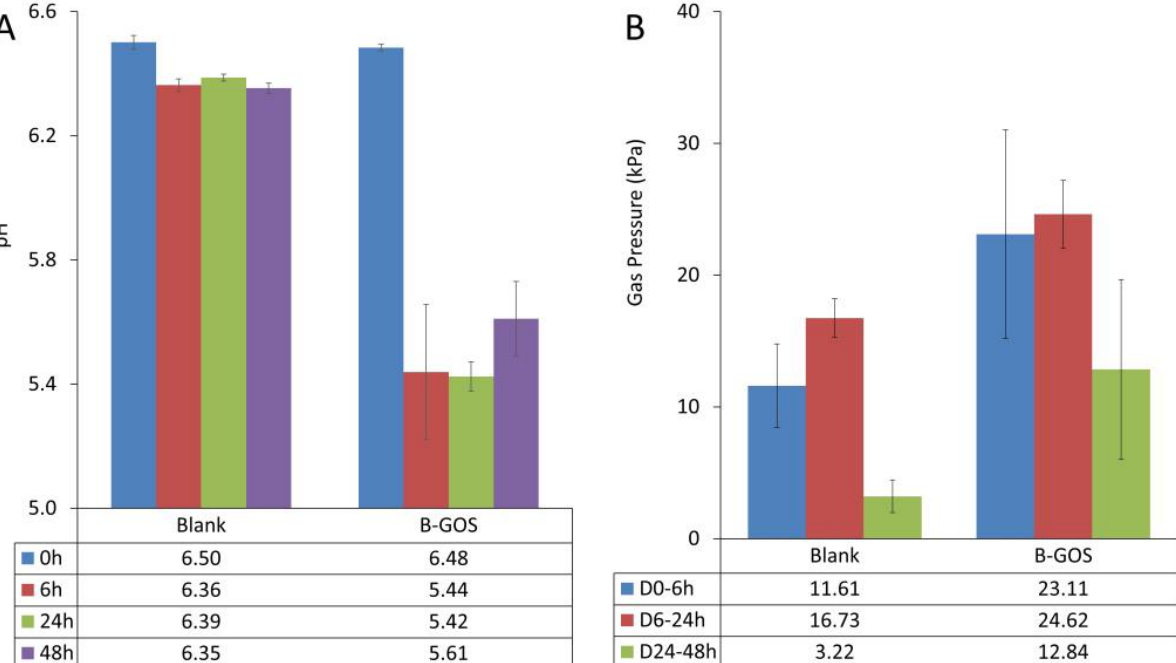
Figure 2. Overall microbial community activity (acidification and gas production) shown as ( A ) pH and ( B ) gas pressure. Measurements were collected in triplicate. Data for average values were derived using data from Donors A/B/C. Error bars represent standard deviation. GOS = Bimuno ® galactooligosaccharide.